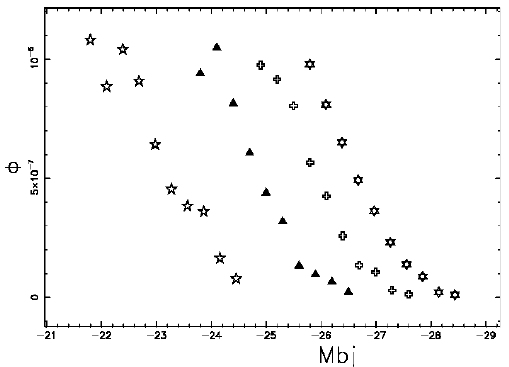
Figure 3. The observed LF for QSOs when z [ 0.3,0.5 ] and M [ − 24.45, − 21.50 ] (empty stars), [ 0.7,0.9 ] and M [ − 26.49, − 23.50 ] (full triangles), [ 1.1,1.3 ] and M [ − 27.59, − 24.60 ] (empty crosses) and [ 1.5,1.7 ] and M [ − 28.43, − 25.50 ] (stars of David).